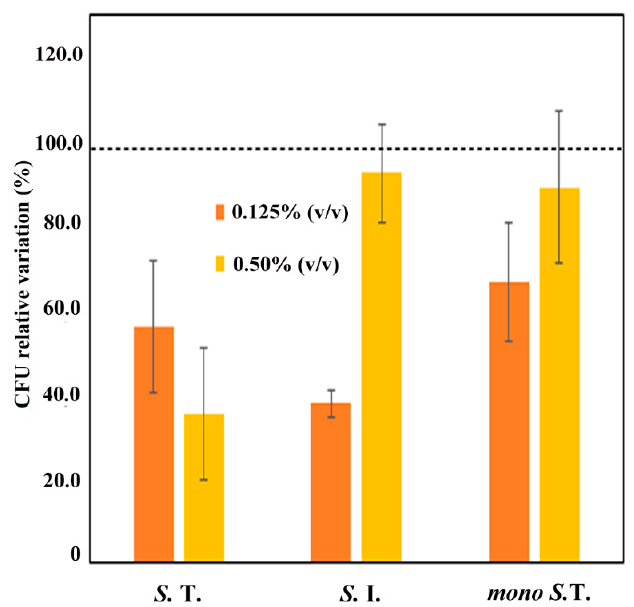
Figure 2. Control-related ratios of the CFU count recovered from GR-OLI-treated bacteria strains (S.T. = S. Typhimurium, S. I. = S. Infantis, mono S. T. = monophasic S. Typhimurium) after the adhesion to the Caco-2 monolayer. Vertical bars indicate ± standard errors.